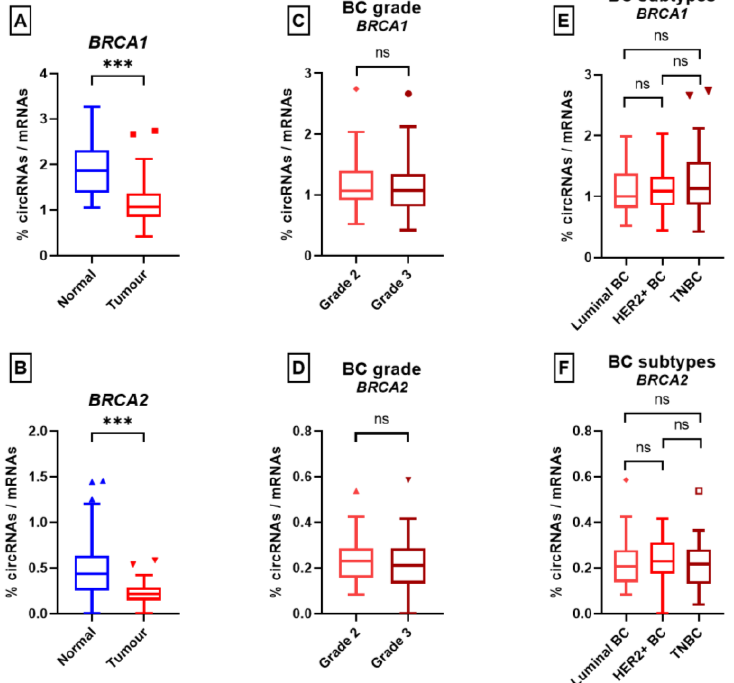
Figure 5. The circular RNA/messenger RNA ratios. Ratios for the normal and tumor tissues are indicated for BRCA1 ( A ) and BRCA2 ( B ). Ratios according to histological subtype (luminal, HER2+, and triple-negative breast cancer (TNBC)) for BRCA1 ( C ) and BRCA2 ( D ). Ratios according to grade are indicated for BRCA1 ( E ) and BRCA2 ( F ). (ns: non-significant; ***: p < 0.001, Student’s t -test). Triangles, squares and circles represent